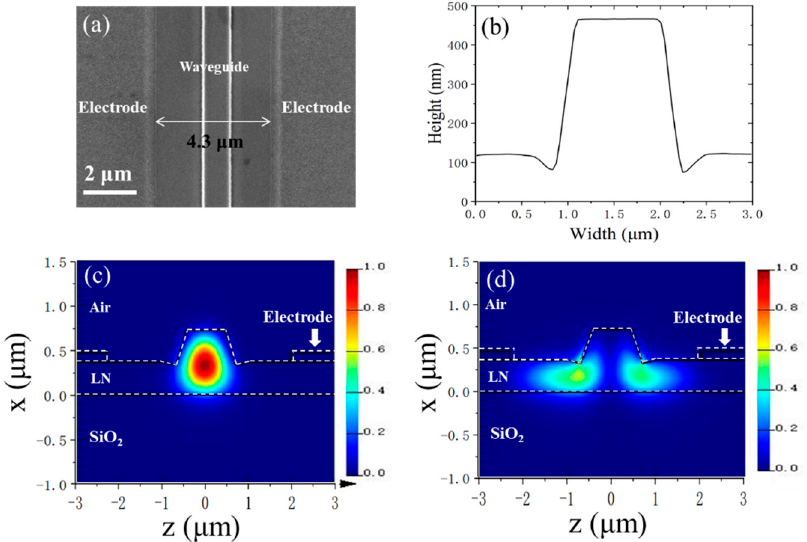
Figure 7. SEM image of phase modulator in grinded LNOI ( a ) and cross-section AFM image of LNOI waveguide ( b ). Simulated electric field distributions of the TE 00 ( c ) and TE 10 mode ( d ) in LN waveguide.